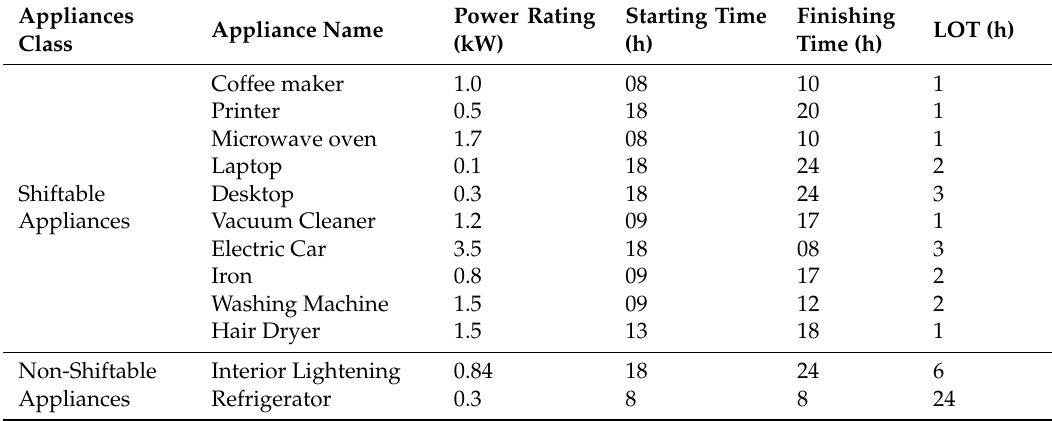
Table 1. Appliances categorization, names, power rating, starting time, finishing time, and Length of operational time